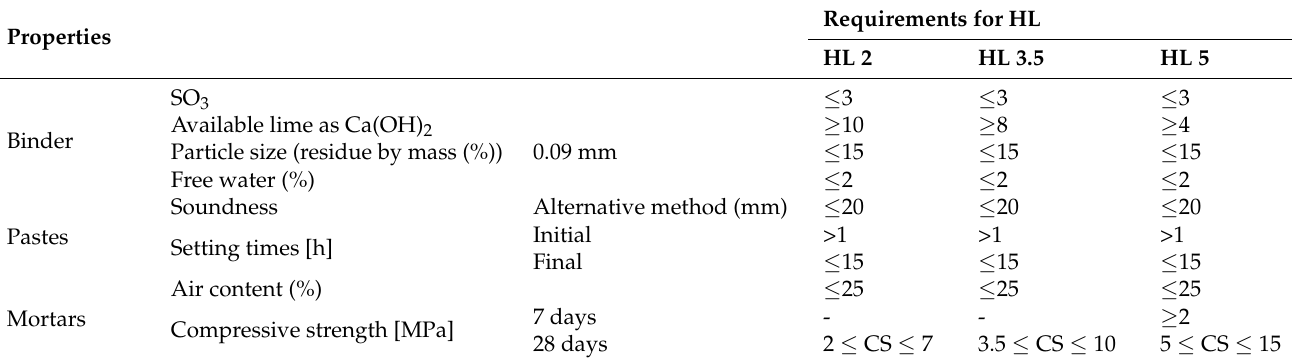
Table 1. Requirements for hydraulic lime (HL) according to standard EN 459-1